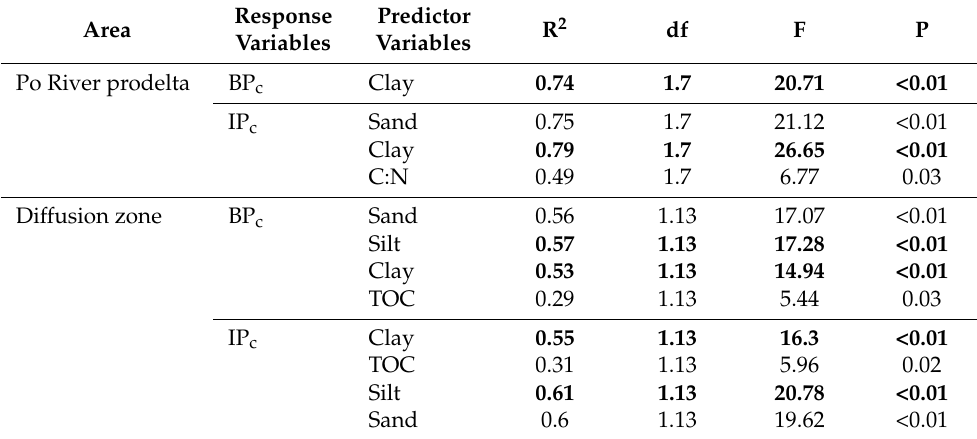
Table 1. Linear regression of bioturbation indices (BP c and IP c ) as response variables and environ- mental parameters as predictor. R 2 : coefficient of determination; df: degrees of freedom; F and P give the calculated F value (F-test) and the corresponding probability associated with the null hypothesis. The negative linear regressions are in bold. TOC-Total Organic Carbon; C:N-carbon and nitrogen ratio. Response Predictor Area R 2 df F P Variables Variables Po River prodelta BP c Clay 0.74 1.7 20.71 <0.01 IP c Sand 0.75 1.7 21.12 <0.01 Clay Diffusion zone BP c Sand 0.56 <0.01 Silt